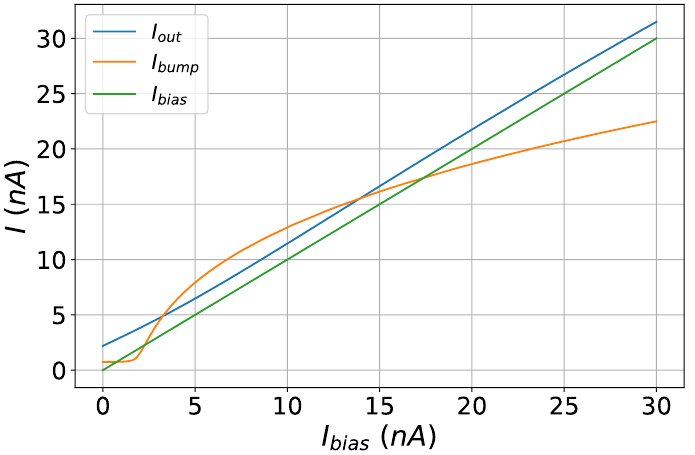
Figure 7. Effect of multiplier on output current of the multidimensional bump circuit. It provides a linear output current that has the same behavior with the I bias